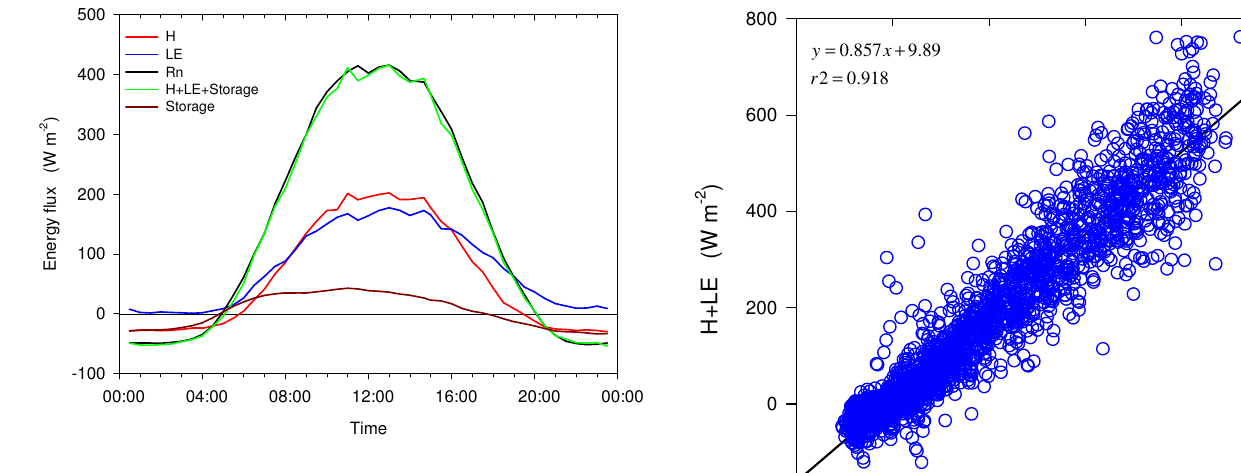
Fig. 7. The average diurnal course of the energy fluxes during June–July 1995.